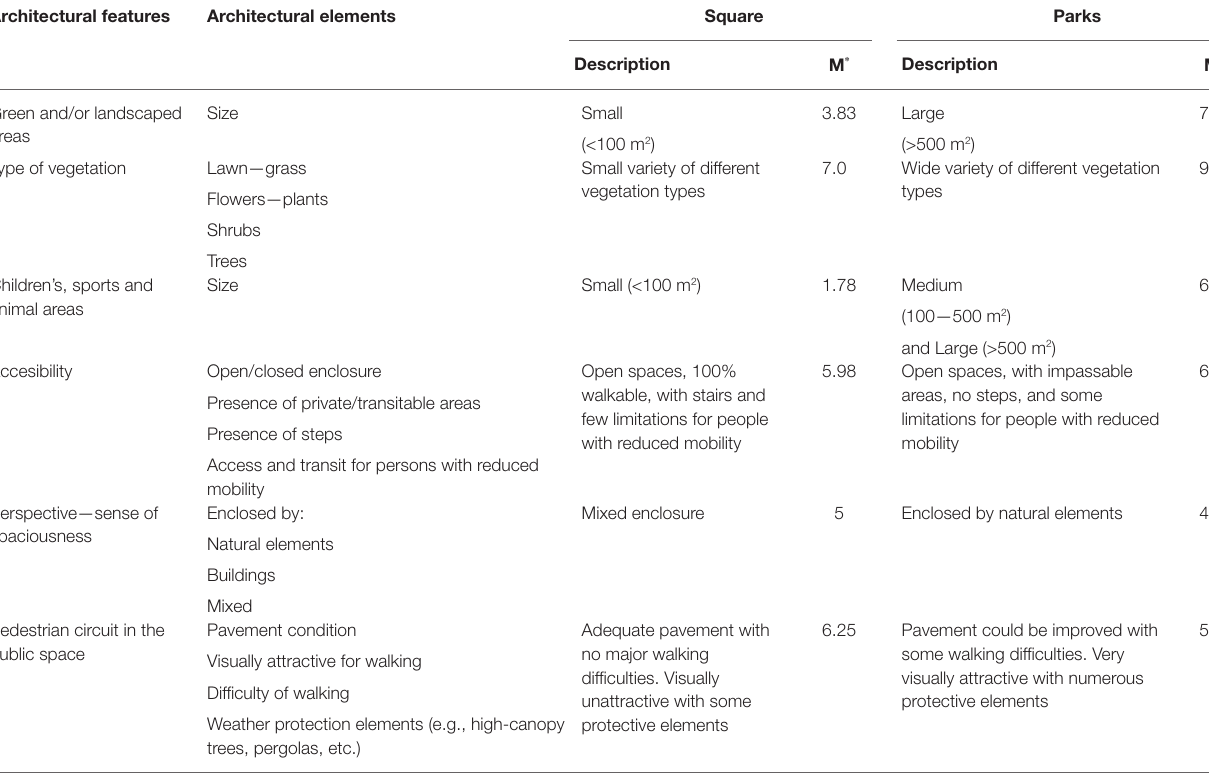
TABLE 2 | Description of evaluated architectural elements of squares and parks through the observation tool. Architectural